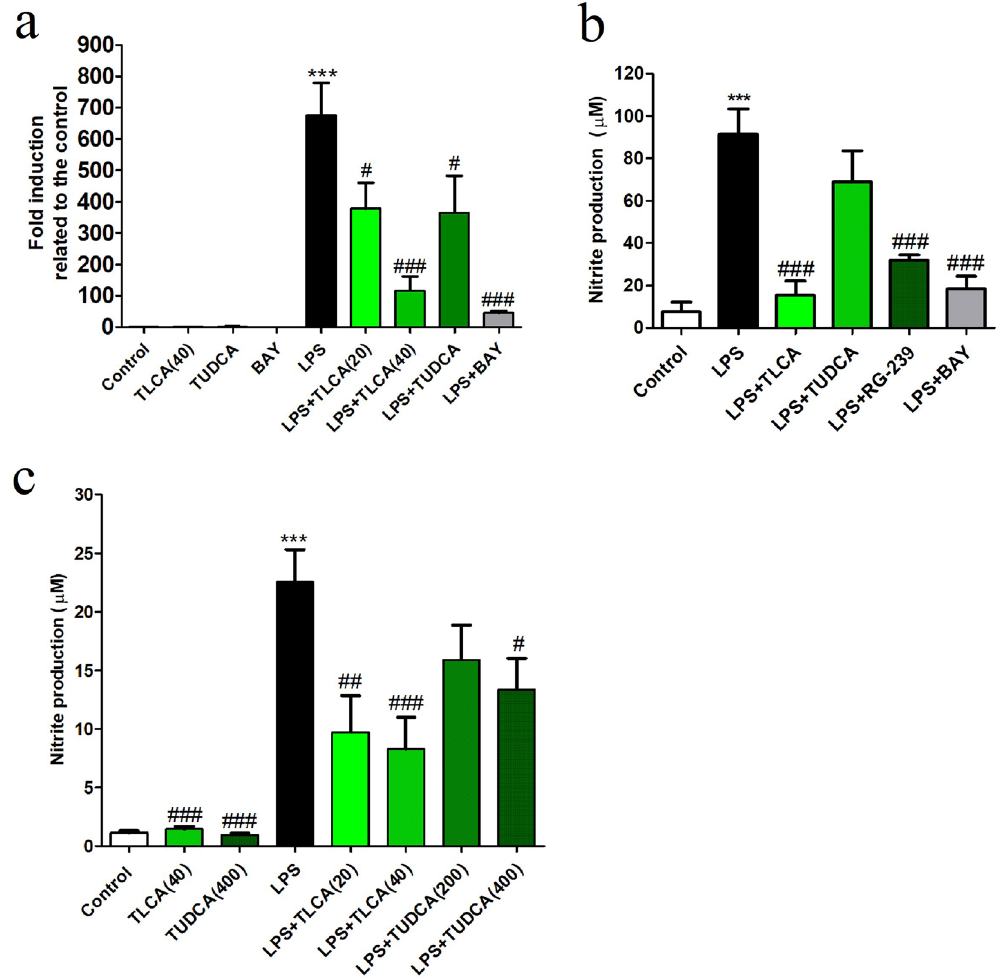
Figure 1. Bile acids inhibit LPS-induced nitrite production in cell cultures. (a) Transcript expression of iNOS was determined in Raw264.7 cells, pretreated with TLCA (20 or 40 µM), TUDCA (200 µM) or BAY11-7042 (5 µM) for 2 h; LPS (50 ng/ml) was added and incubated for 24 h. Concentrations of iNOS transcripts were normalized to expression of RPS29 and the control condition without LPS (mean ± SEM, n ≥ 4 experiments). ANOVA revealed significant treatment effects on iNOS expression [F (7, 31) = 11.9, p < 0.001). (b) Nitrite production (in µM) by Raw264.7 cells was strongly induced by LPS and significantly inhibited by TLCA and the specific TGR5 agonist RG-239 (2 µM) [F (5, 20) = 15.0), p < 0.001]. (c) In microglia primary cultures, nitrite release (µM) was also induced by LPS (10 ng/ml) and inhibited by bile acids [F (7, 73) = 15.9, p < 0.001]. Statistical significance of post hoc Dunnett’s tests is indicated significance between treatments and the controls *** p < 0.001 (control vs. LPS) and # p < 0.05, ## p < 0.01 and ### p < 0.001 (LPS vs. LPS +